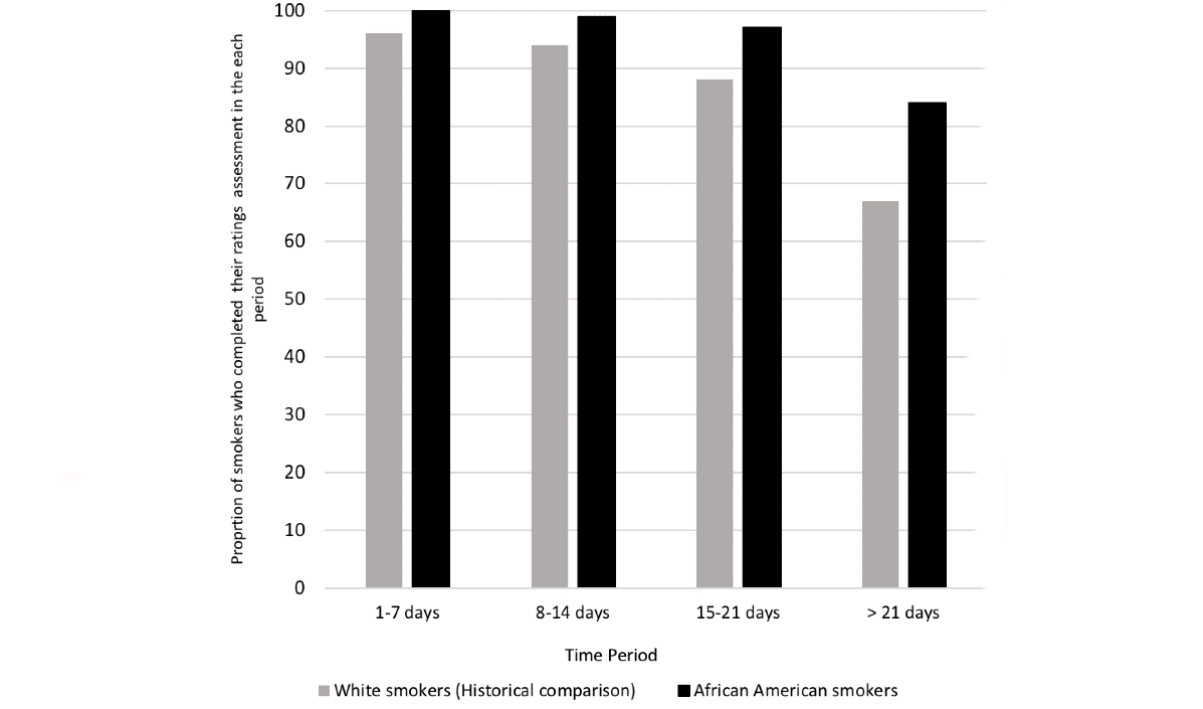
Figure 1. Proportion of people who smoke completing ratings assessments by study time periods.